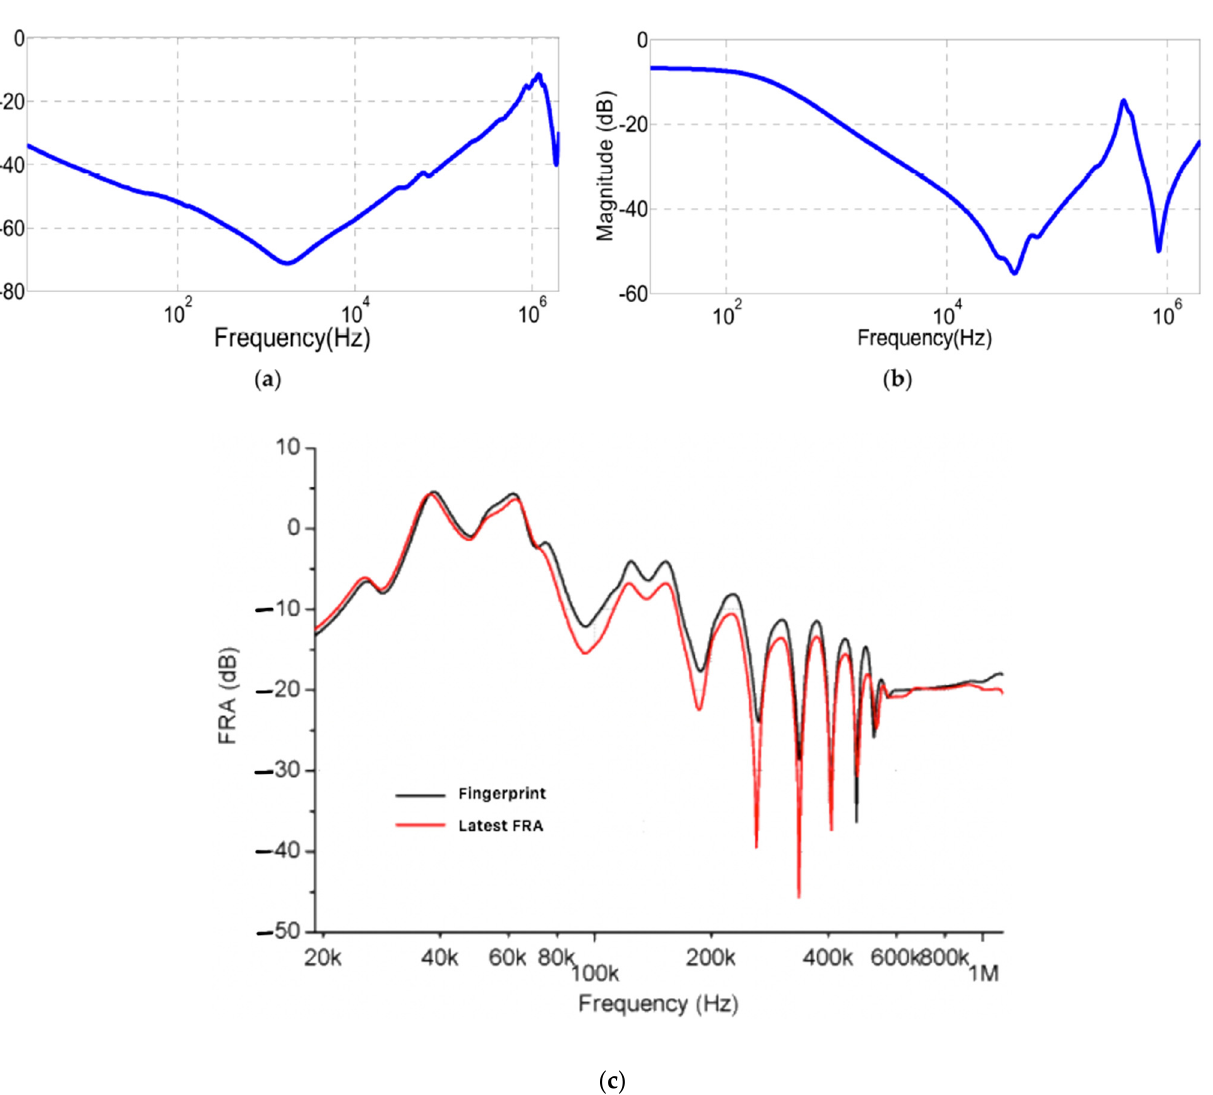
Figure 3. ( a ) Open-circuit FRA response and ( b ) short-circuit FRA test response; ( c ) FRA measurement setup.